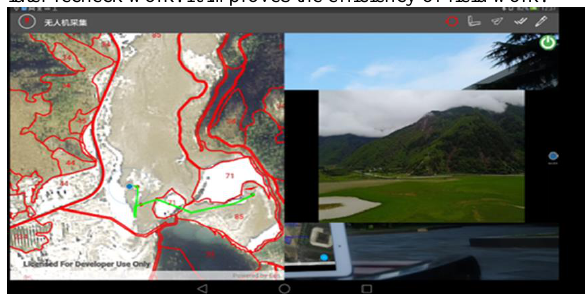
Figure 1. UAV field route planning, flight control and flat map editing interface